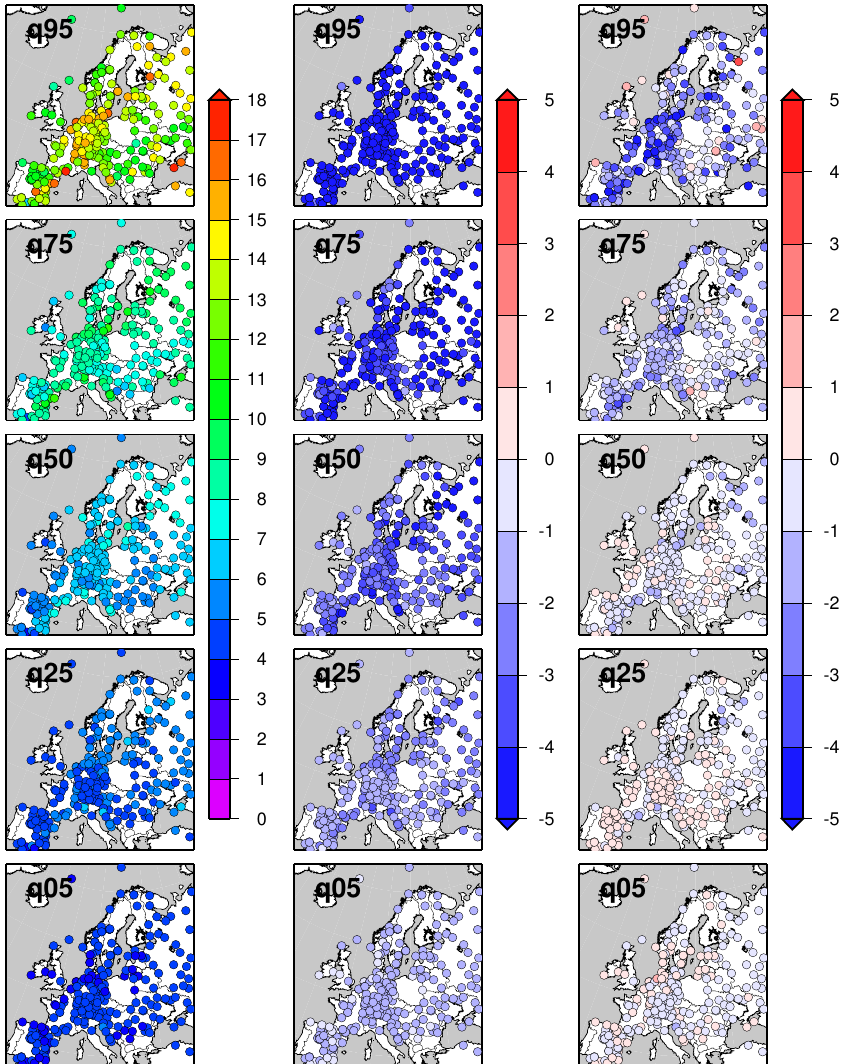
Fig. 4. Left column: 5th, 25th, 50th, 75th and 95th quantiles of summer τ (first non-positive autocorrelation lag) in ECA&D observations (in days). Central column: differences of quantiles of τ between observed and simulated temperature anomalies with “static” weather generator. Right column: differences of quantiles of τ between observed and simulated temperature anomalies with “dynamic” weather